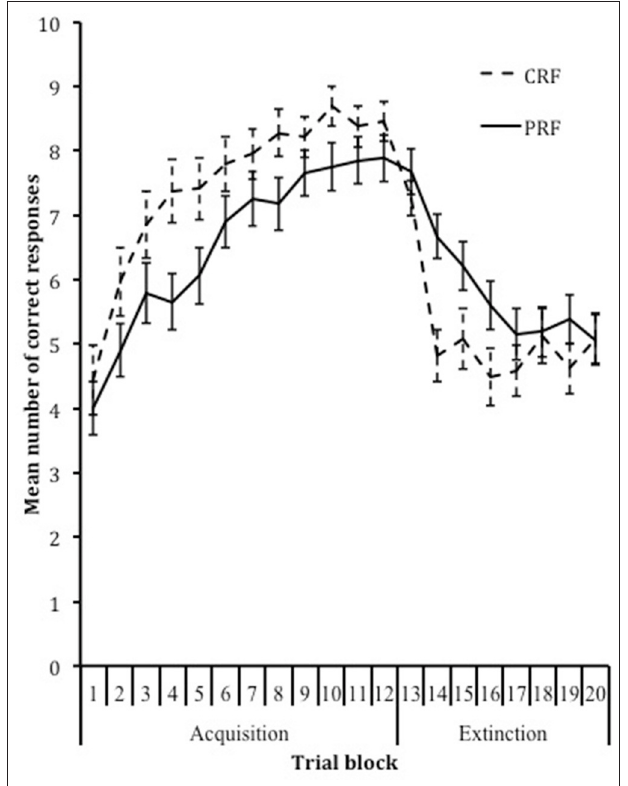
FIGURE 2 | Acquisition and extinction of the response over trial blocks in the CRF and PRF